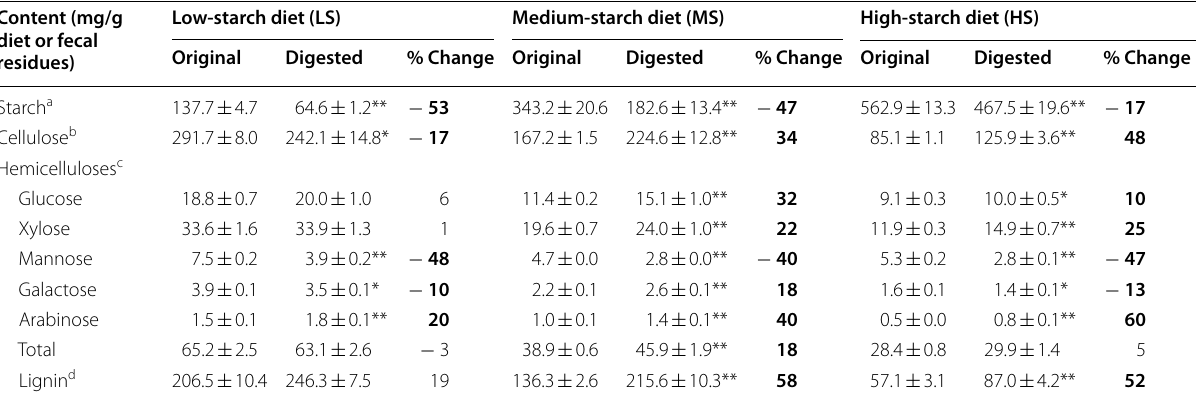
Table 2 Starch and lignocellulose compositional analyses of original artificial diets and fecal residues of N. hirtum larvae